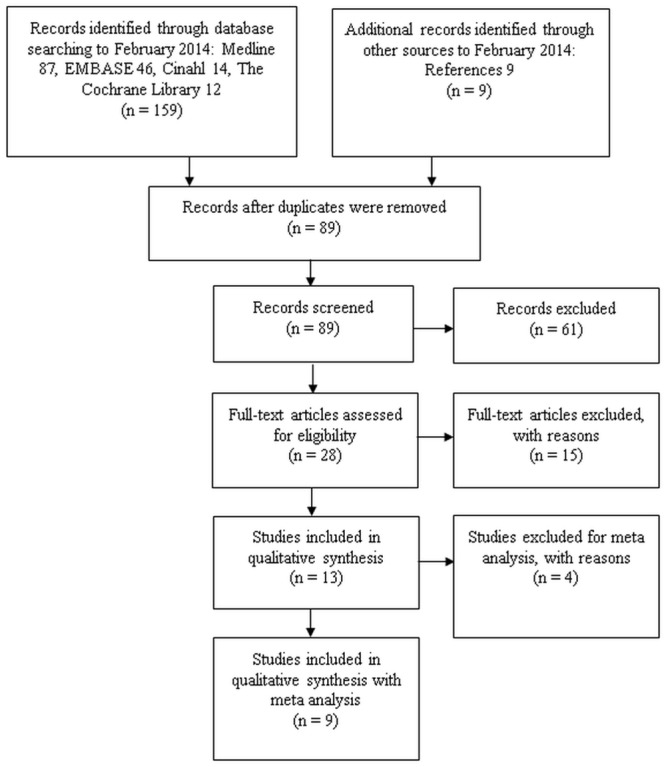
Selection of articles for the systematic review on nutritional status in NHD patients.